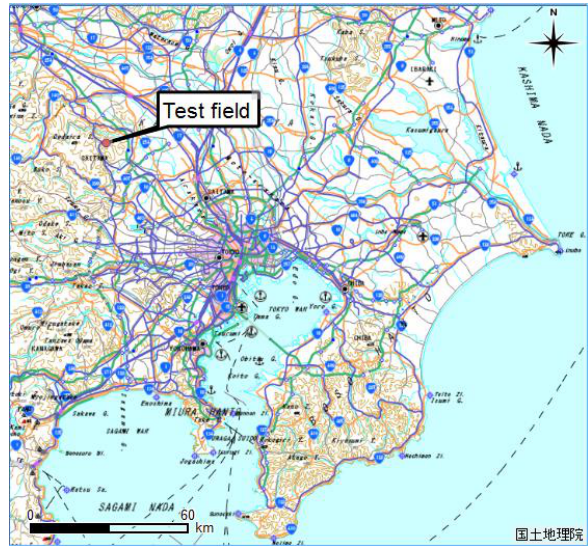
Figure 2. Test field location